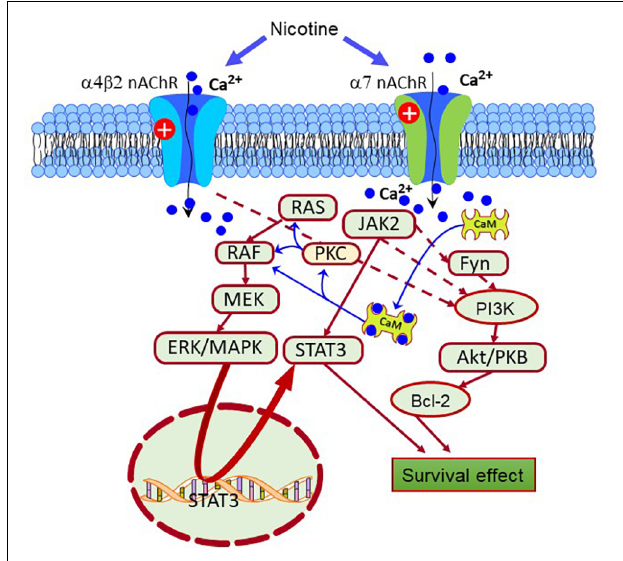
FIGURE 2 | Scheme depicting different pro-survival signaling pathways activated by the nAChRs. Nicotine-induced neuroprotection is mediated by receptors, primarily through the α 7 and α 4 β 2 receptors. Also, the nAChRs can activate intracellular pathways that enhance the expression of pro-survival proteins that inhibit apoptosis. From them, Janus kinase 2 (JAK2), Fyn, protein kinase C (PKC), and calcium-calmodulin kinase (CaMK) are crucial protein factors triggering the activation of the extracellular signal-regulated protein kinase (ERK), JAK2/signal transducer, and activator of transcription 3 (STAT3), and phosphatidylinositol 3-kinase (PI3K)-Akt pathways. In turn, these pathways enhance the expression of antiapoptotic factors such as